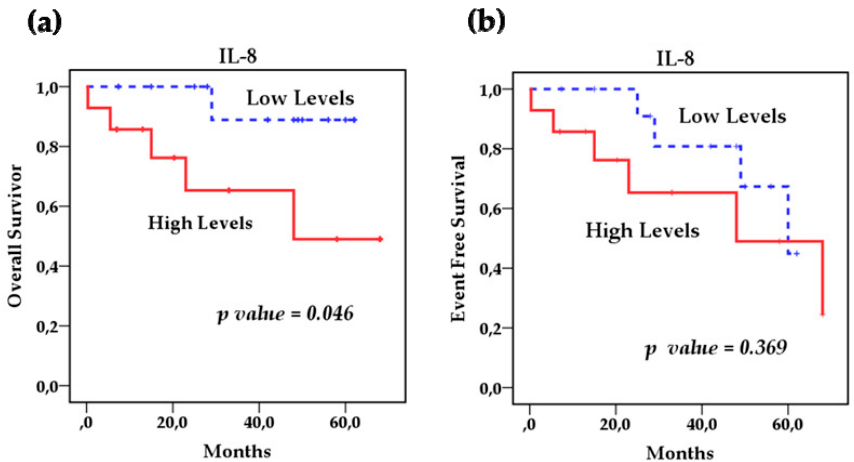
Figure 6. Kaplan–Meier curves comparing patients with high levels against those with low levels of IL-8: ( a ) Overall survival (OS) and ( b ) event-free survival (EFS). Table 9. Results of the multivariate Cox proportional hazards model.